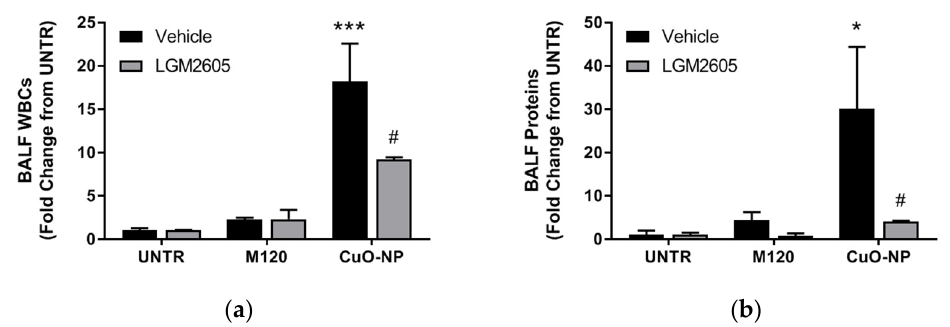
Figure 9. Mitigation of CuO-NP-induced acute lung injury by LGM2605. ( a ) BALF WBCs; and ( b ) BALF protein levels determined at 24 h following instillation of inert carbon control (M120) or 15 µ g CuO-NPs. LGM2605 (100 mg/kg) was administered 1 h post-CuO-NP exposure. All data